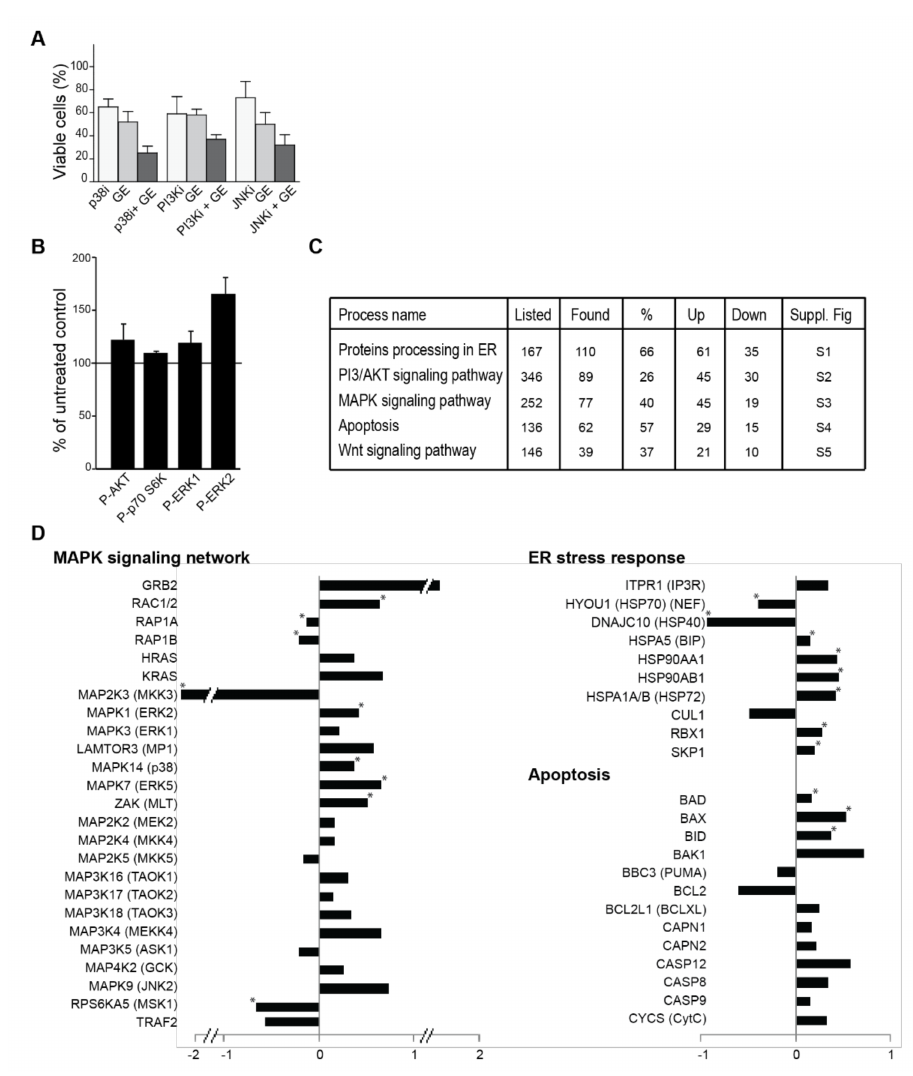
Figure 3. GE influences cellular signalling. ( A ) The viability of JJN3, measured by MTT-assay on day three after the addition of GE diluted 1:4000 in combination with p38 (SB20358, 10 µ M), PI3K (LY294002, 7 µ M), and JNK (SP600125, 10 µ M). The viability of the different cell lines in growth media with equal amounts of DMSO, as in 10 µ M kinase inhibitor, are similar to the control. The mean relative viability ± SD of 3–6 technical replicas are shown. ( B ) Quantification of the western analysis of cell extracts from 67NR cells, treated with different dilutions of GE (1:1000) for 24 h, compared to untreated control. The % phosphorylated Akt (Ser473), ERK1 (Thr202/Tyr204), ERK2 (Thr185/Tyr187), and S6K (Thr389) extracts from the untreated control (100%, black horizontal line) are shown. Data represents mean ± SD from three biological replicas. ( C ) Relevant cellular pathways from KEGG. Numbers of proteins listed in each pathway, as well as the number and percentage of found proteins are given. our quantitative date into KEGG pathway diagrams are shown in the corresponding Supplementary Table S1 is shown as log2 values of changes in protein levels relative to the control. * indicate significant changes, according to a two-sided non-parametric Wilcoxon Sign Rank Test, as described in [32] ( n =